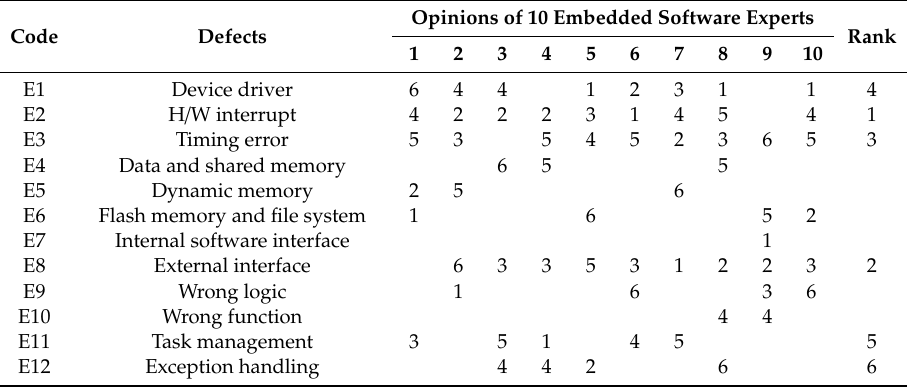
Table 14. Opinions of embedded software development experts on important